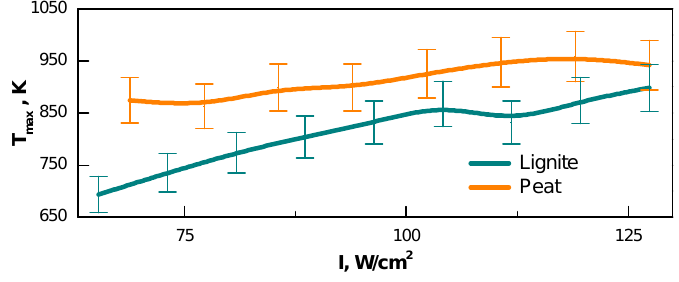
Figure 2. Fuel surface temperature vs. light flow intensity during